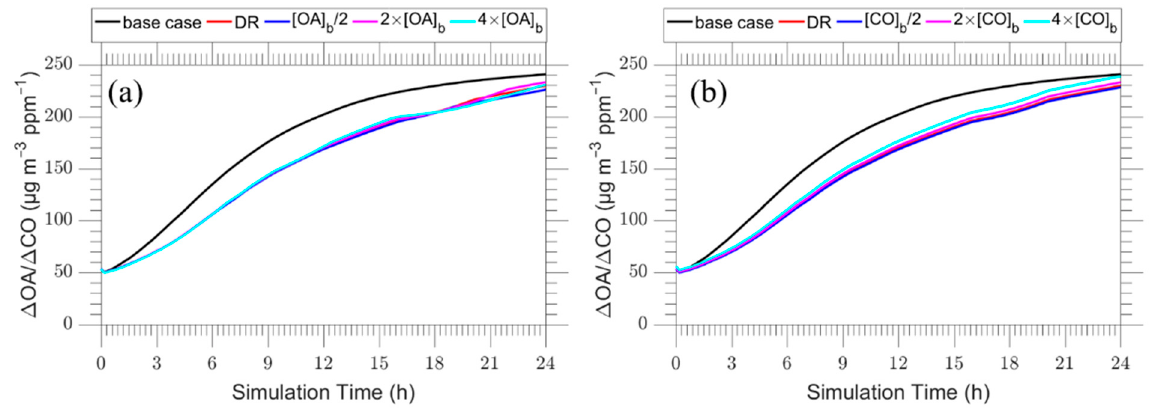
Figure 11. Time series of Δ OA/ Δ CO for the plume centerline for the: ( a ) increased background OA cases by a factor of 2 (magenta line) and 4 (cyan line) and decreased background OA case by a factor of 2 (blue line) and ( b ) increased background CO cases by a factor of 2 (magenta line) and 4 (cyan line) and decreased background CO cases by a factor of 2 (blue line). The base dilution case ( red line ) and overall base case ( black line ) are also shown.